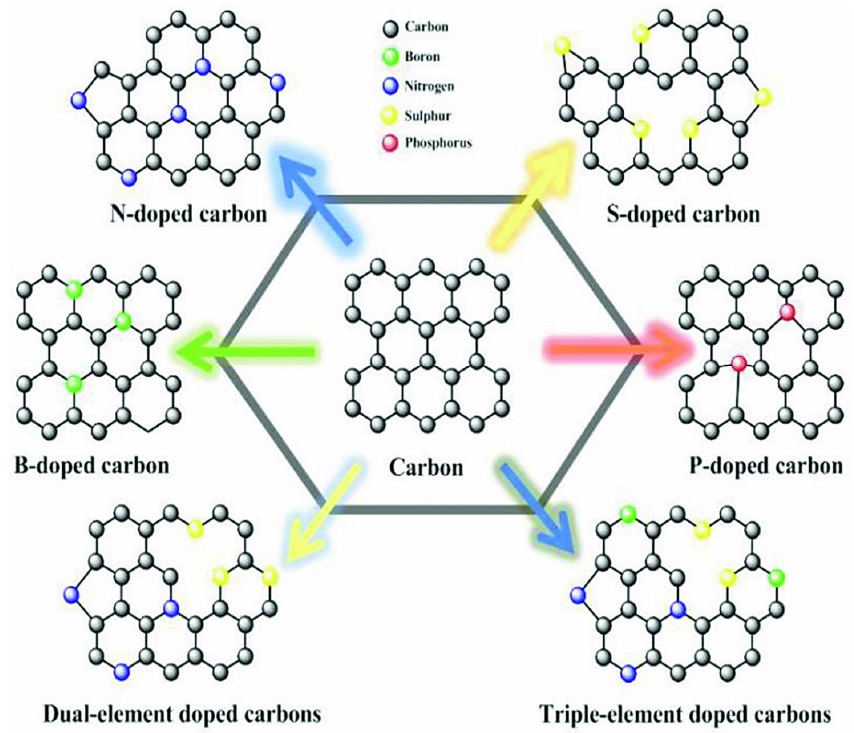
Figure 10. A schematic representation of carbon with different heteroatoms [68], open